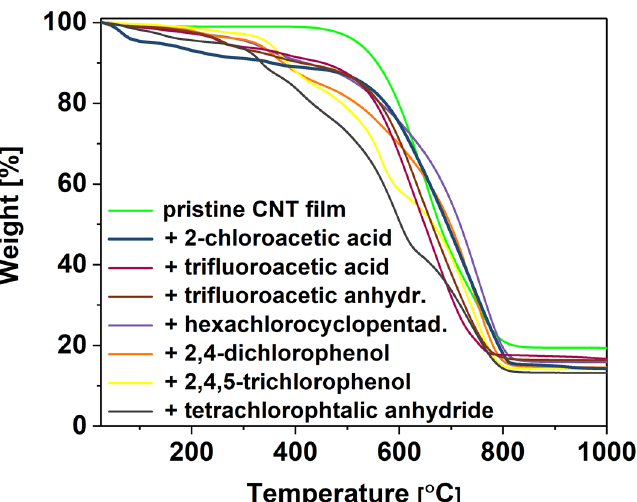
Figure 3. Thermograms of a pristine CNT film and CNT films after doping with organic halide